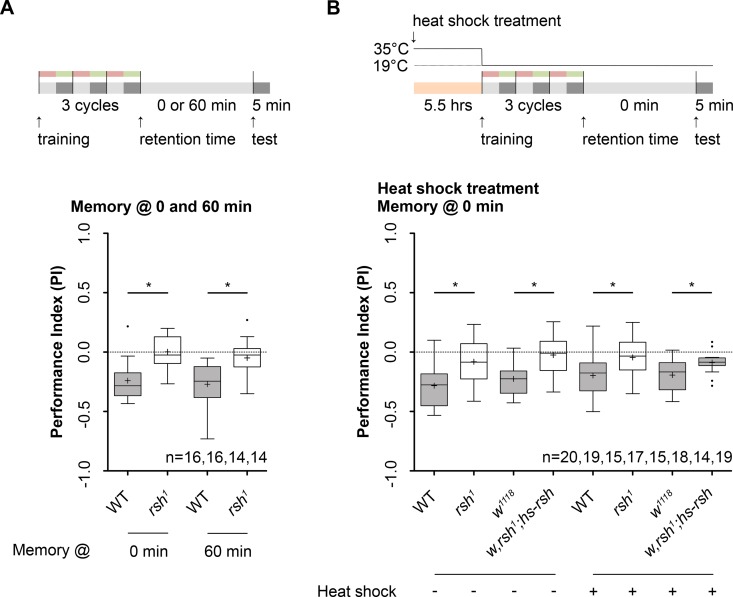
Odor-high salt learning and/or memory depends on radish gene functionTraining and temperature protocols are shown at the top of each panel. A: In contrast to wild type larvae, aversive olfactory learning and/or memory is impaired in rsh1 mutants tested 0 and 60 minutes after three cycle standard training (One sample t test, p = 0.95 tested at 0 minutes, p = 0.31 tested at 60 minutes). B: Rescue experiment of rsh1 learning and/or memory phenotype using a hs-rsh transgene. The transgene was induced via a heat-shock of 35°C for 5.5 hours (continuous line). The control group was kept at 22°C for 5.5 hours (dashed line). Without heat-shock experimental animals (rsh1, w,rsh1;hs-rsh) tested 0 minutes after three cycle standard training distributed randomly (One sample t test, p = 0.09 for rsh1, p = 0.52 for w,rsh1;hs-rsh). Yet, both genetic controls showed an aversive memory (One sample t test, p<0.0001 for wild type, Wilcoxon signed rank test, p = 0.0001 for w1118). After heat-shock application only rsh1 mutants distributed randomly (One sample t test, p = 0.25). Yet, ubiquitous induction of rsh expression partially rescues the learning and/or memory phenotype (One sample t test, p = 0.0009, unpaired t test, p = 0.01 comparing w,rsh1;hs-rsh and w1118). Both control groups showed a memory performance above chance level (One sample t test, p<0.0001 for wild type, p<0.0001 for w1118). Differences between groups are depicted above the respective box plots, at which ns indicates p≥0.05 and * p<0.05. Grey boxes show memory performance above chance level (p<0.05), whereas white boxes indicate random distribution (p≥0.05). Small circles indicate outliers. Sample size is n = 16 for each group if not indicated otherwise.